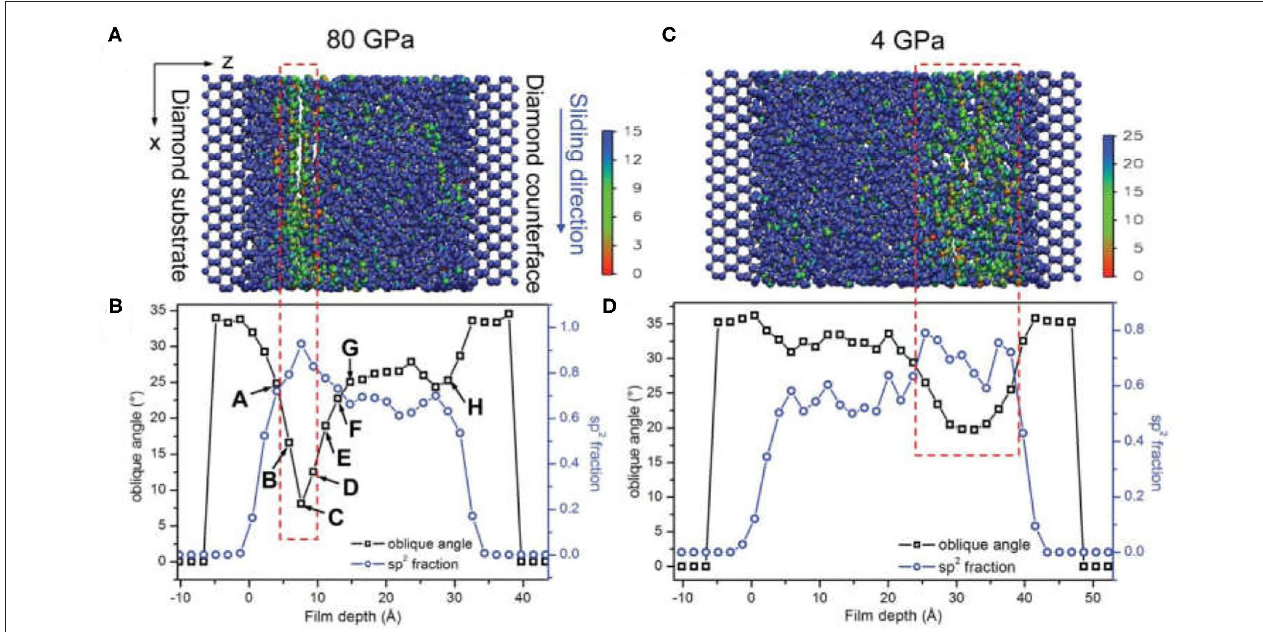
FIGURE 7 | Shear localization and phase transformation of a-C films at different contact pressures. (A,C) System snapshots for 80 and 4 GPa. (B,D) Depth profiles of averaged C-C covalent bonding orientation angle and sp 2 fraction. Adapted with permission from Ma et al. (2015) Copyright 2015, the authors.